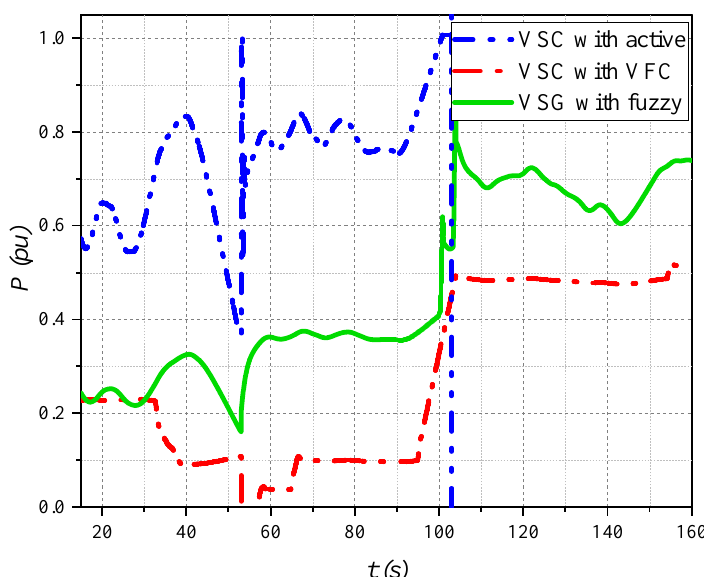
Figure 37. DER 1 output active power for the various scenarios presented in Section